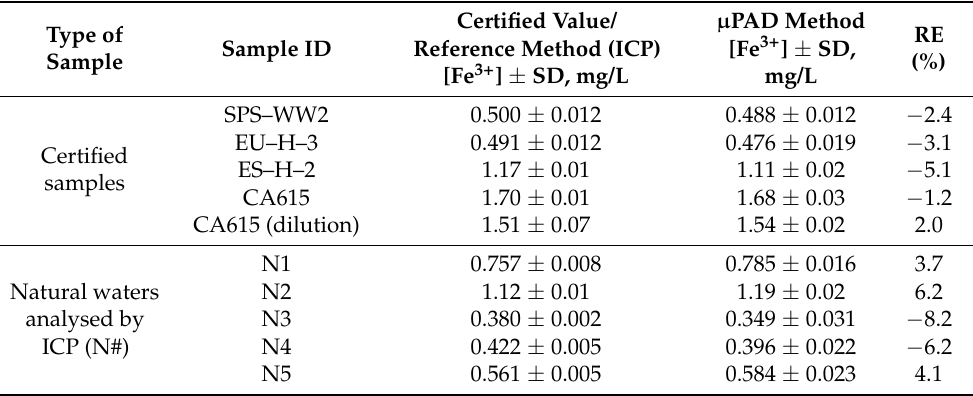
Table 2. Analysis results of certified samples and several natural water samples using the newly developed µ PAD method for iron determination; ICP, inductively coupled plasma; RE, relative error; SD, standard deviation (n =